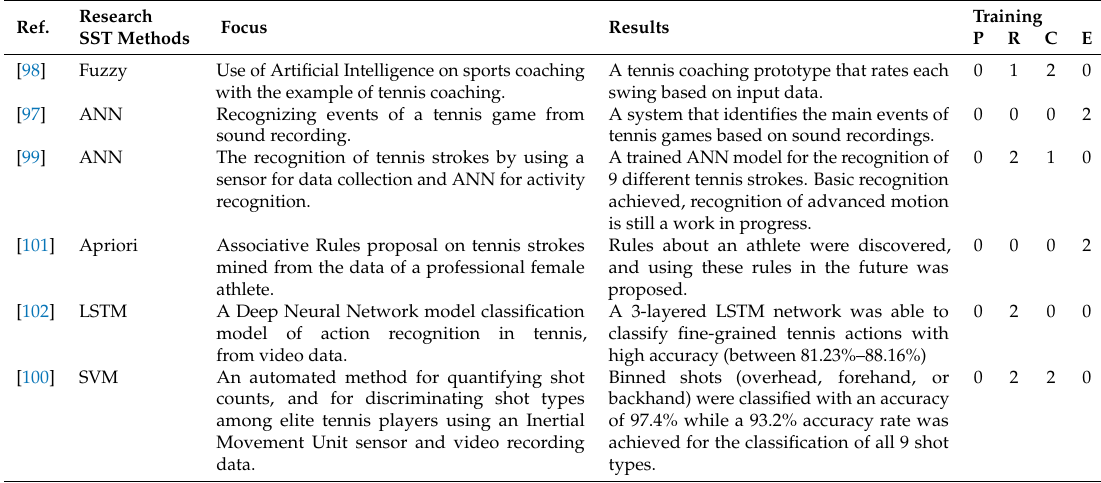
Table 14. Identified studies in the domain of tennis.